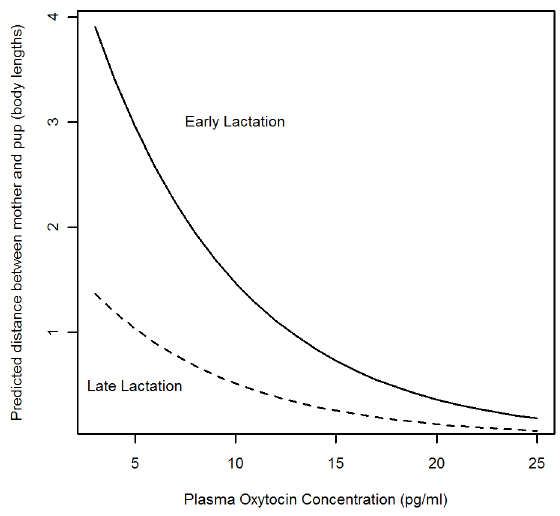
Table 4. Significant fixed effect variables from the only GAMMs for maternal behaviour where plasma oxytocin concentrations significantly impacted on the dependent variable, their estimates, standard errors and p values. Model Number: Dependent variable Model 1: MPD